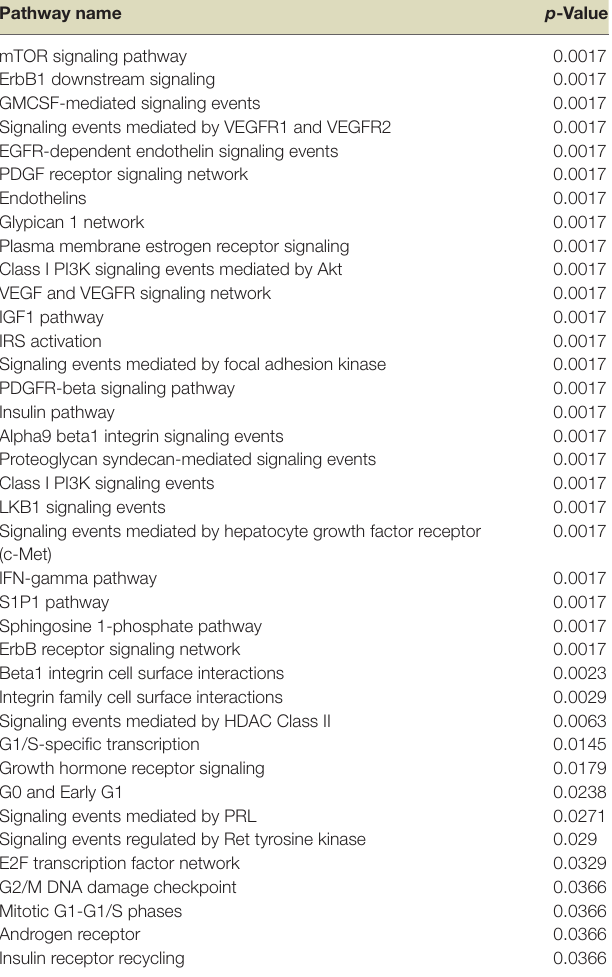
Table 2 | Enriched signaling pathways following ligand stimulation in ECC-1 cells. Pathway